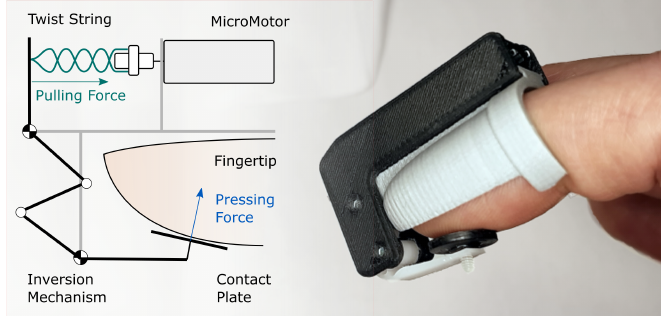
Figure 1. Scheme and developed prototype of the proposed actuation method implementing a twist string actuator and a flexure hinges inversion mechanism for a fingertip haptic